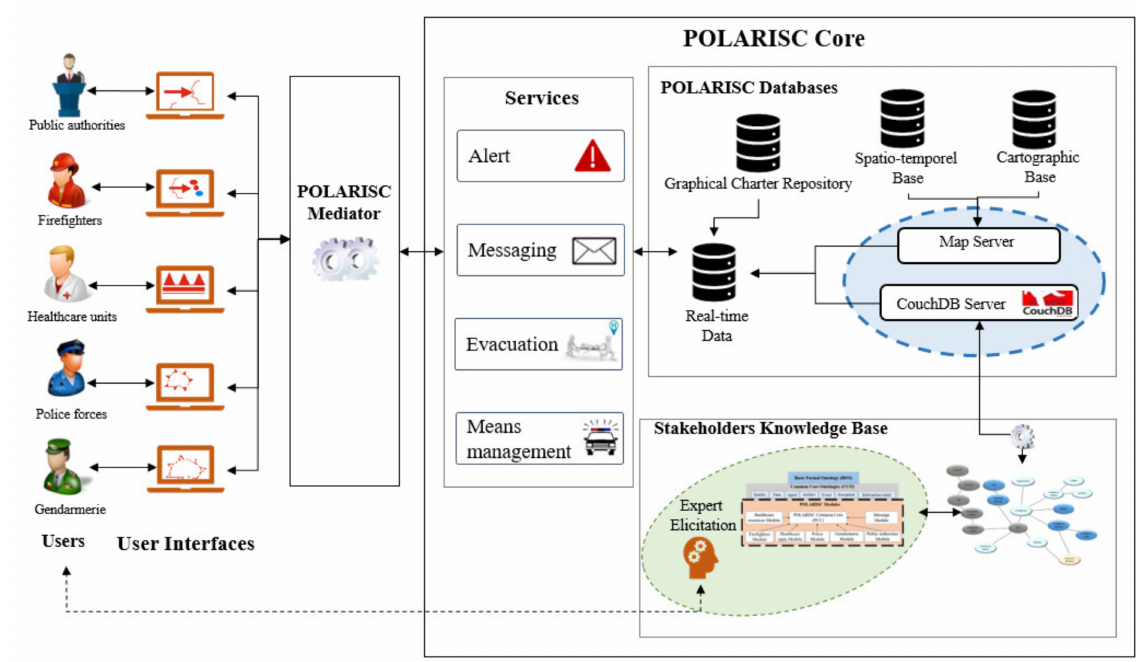
Figure 1. POLARISC